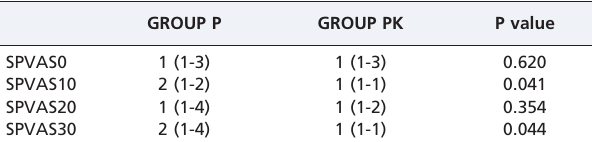
Table 5 - Surgical pain VAS values (SPVAS) (median, minimum-maximum).